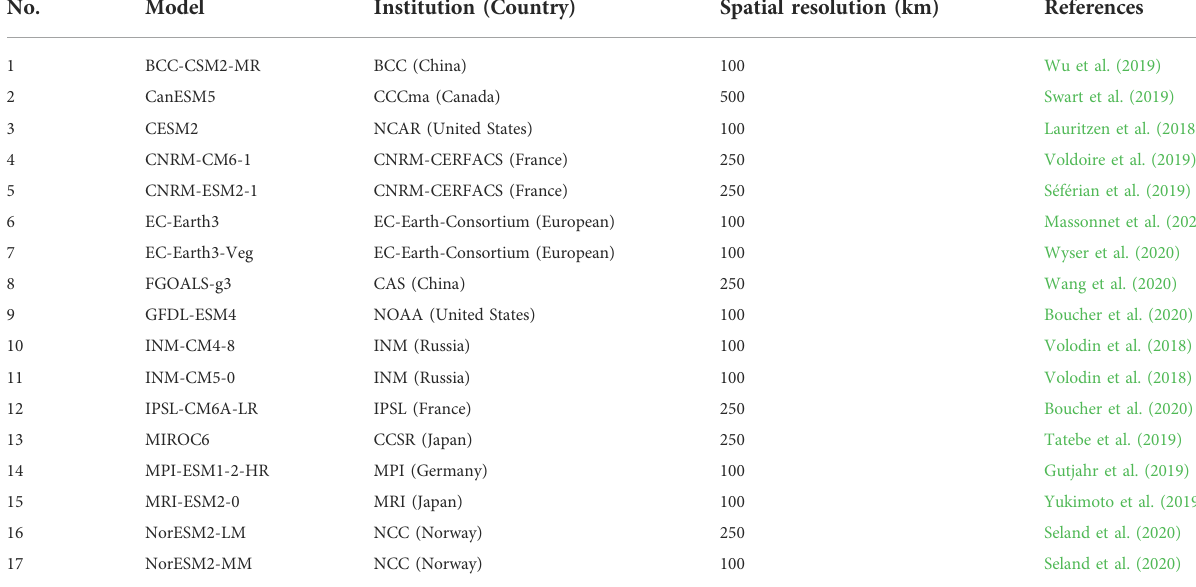
TABLE 1 Basic information of 17 CMIP6 global climate